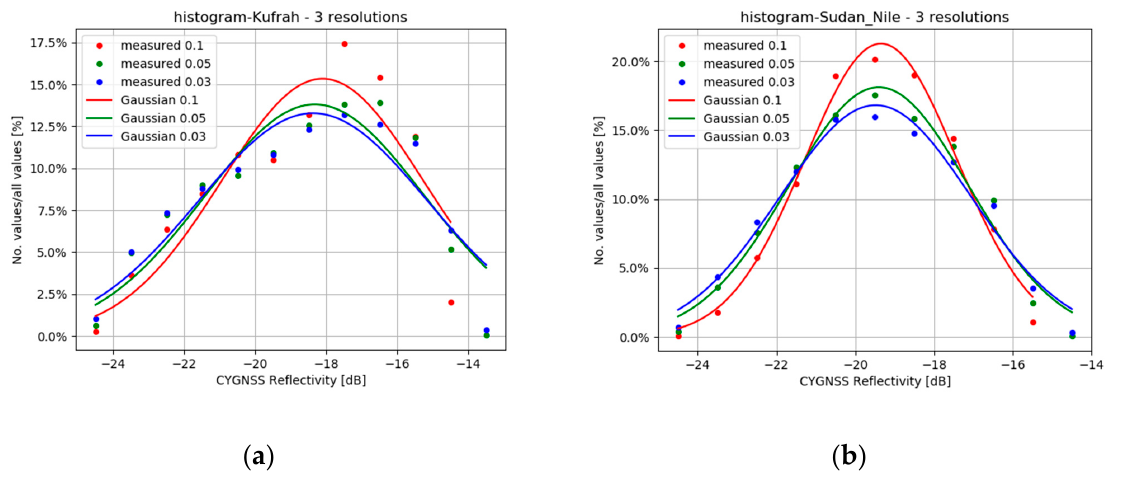
Figure 4. Reflectivity histograms for three spatial resolutions: 0.1°, 0.05° and 0.03°, at two different locations: ( a ) Kufrah area (Libya), ( b ) Sudan-Nile area.